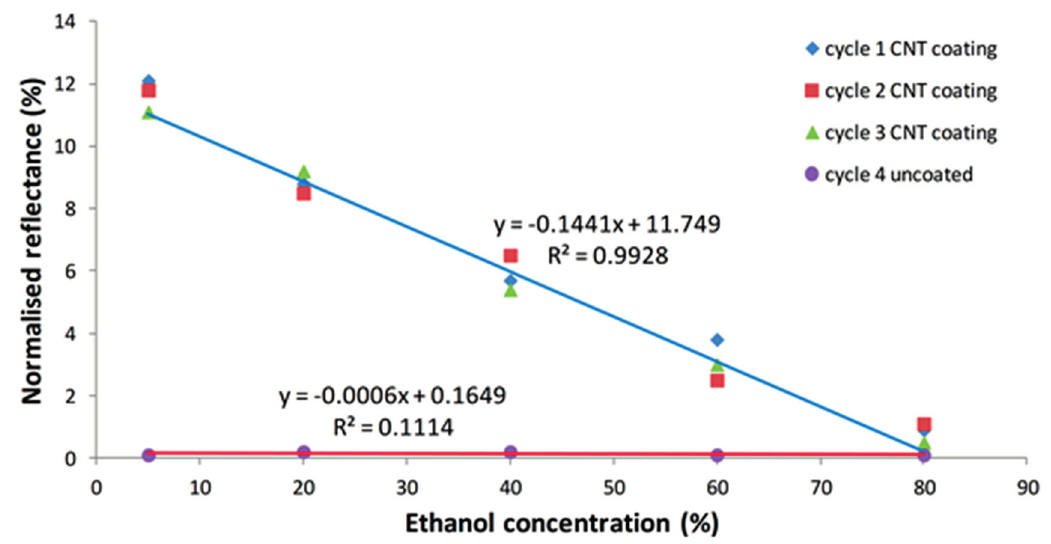
Figure 13. Reflectance changes against ethanol concentrations of blank tapered and CNT coated tapered